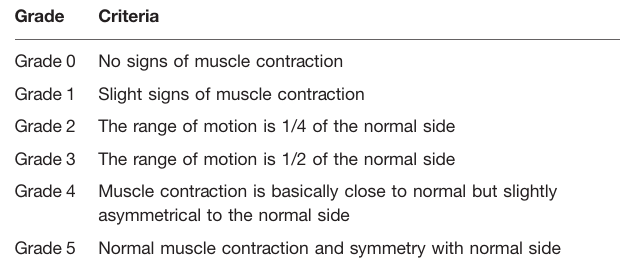
TABLE 2 | MMT muscle strength grading criteria.